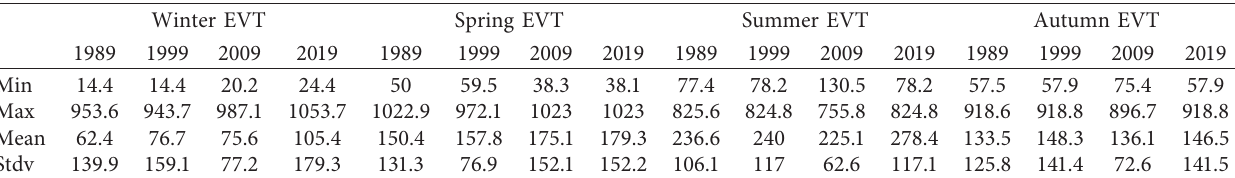
Table 9: Long-term seasonal WetSpass-M simulated EVT (mm) for a LULC (1989, 1999, 2009, and 2019). Winter EVT Spring EVT Summer EVT Autumn EVT